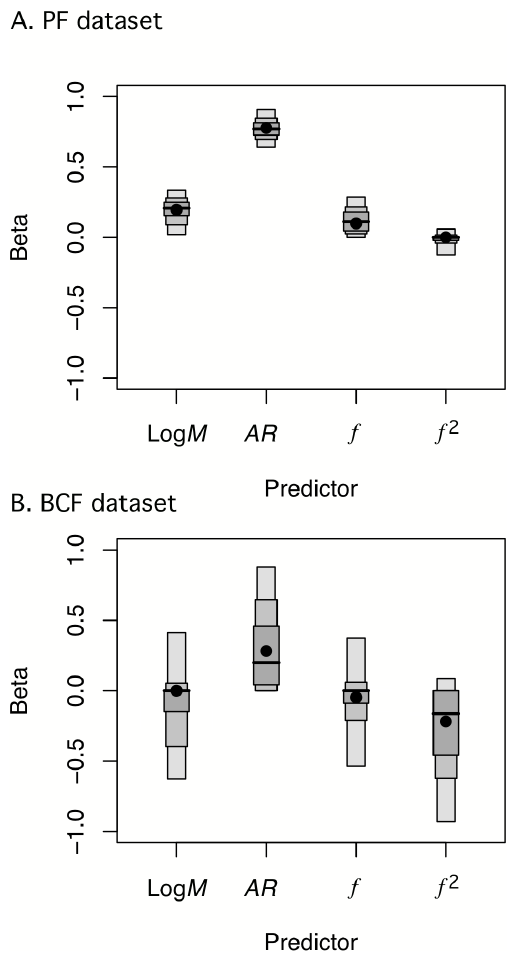
Figure 4. Box-percentile plots of the distribution of model- averaged b coefficients. The distribution is from 5000 bootstrap samples of maximum prolonged-swimming speed (log U max ) regressed on the predictor variables. For each bootstrapped pseudosample, the model-averaged b coefficients were computed from all retained (AICc $ min(AICc) + 2) models in which the variable was included in the model. The outer, intermediate, and inner boxes represent the 95%, 75%, and 50% confidence intervals, respectively. The dashed line represents the median and the dot represents the observed value (Table 3). The scale of the ordinate is the same between (A) and (B) to emphasize the greater variance in the estimates in the BCF subset. Predictor variables are log M (body Mass), AR (propulsive fin aspect- ratio), f (body fineness ratio), and f 2 .